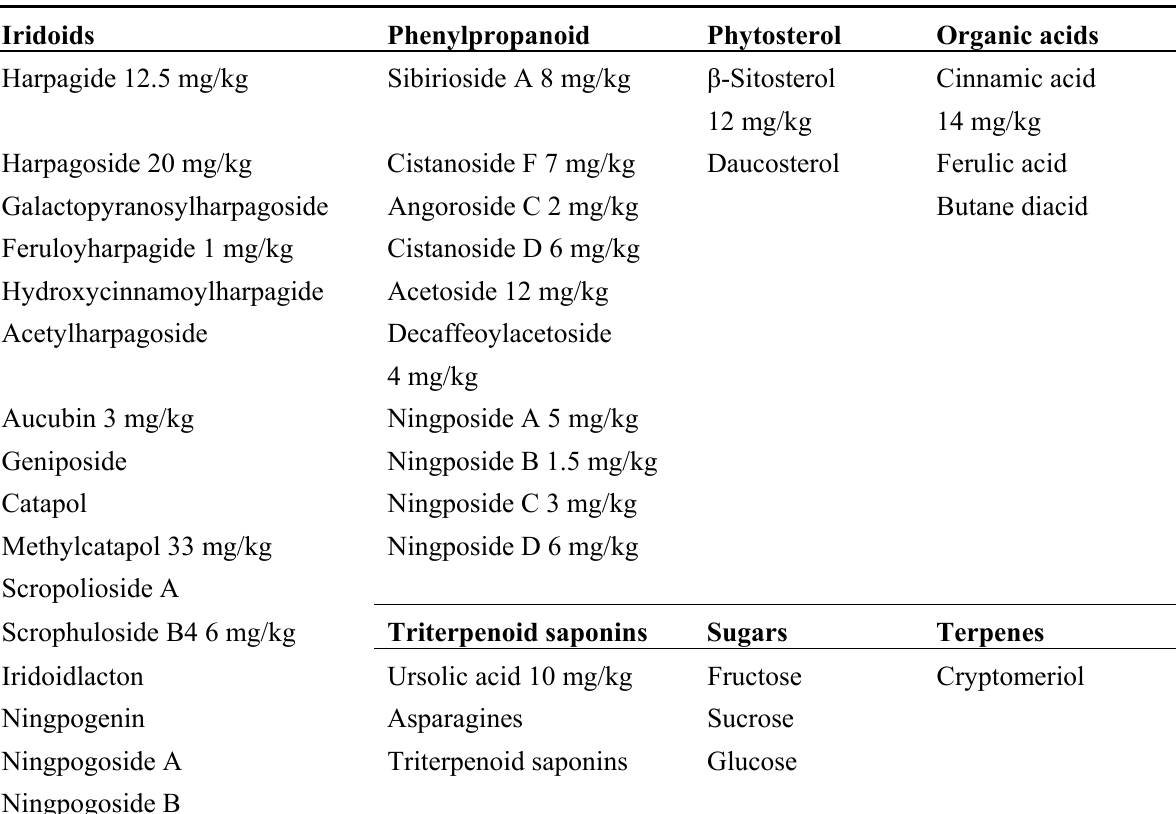
Table 1. Main chemical composition and their approximate amount in RSN